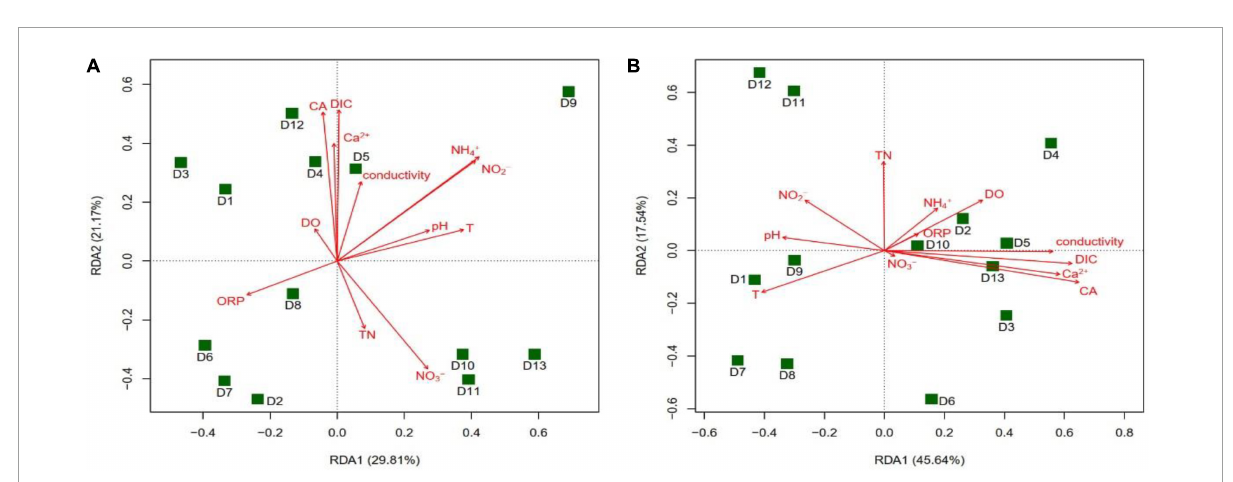
FIGURE9 Redundancy analysis (RDA) of the cbbM gene-containing CO 2 -fixing bacterial community structures with environmental factors in the Huixian karst groundwaters. (A) Winter (201801); (B) Summer